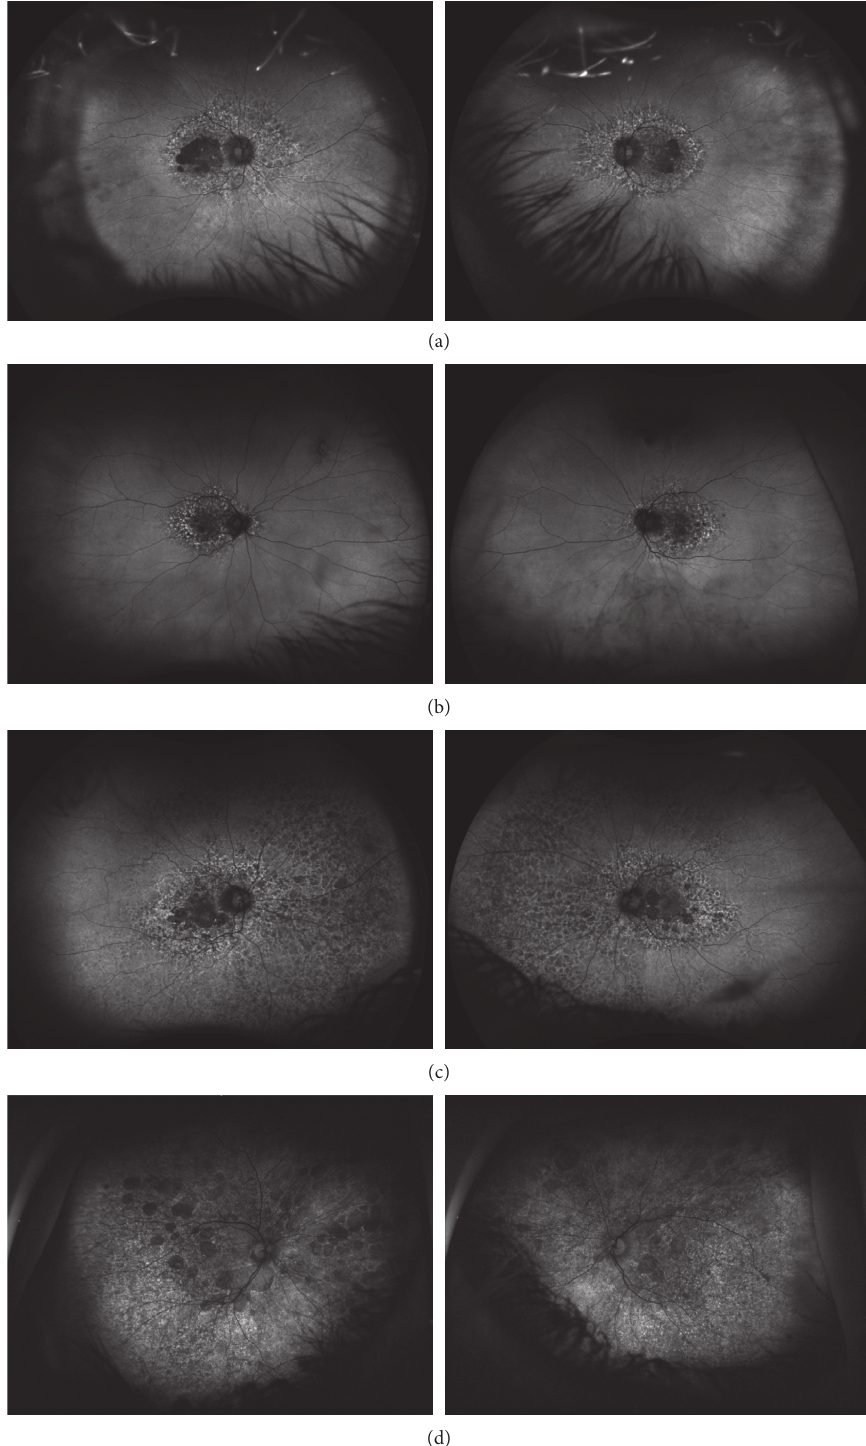
Figure 3: Ultrawidefield fundus autofluorescence imaging demonstrates lobules of absent autofluorescence in the macula of both eyes in patient 1 (a), patient 2 (b), patient 3 (c), and patient 4 (d). These lobules of macular atrophy are surrounded by a larger area of hyper- and hypoautofluorescent changes in the posterior pole of both eyes involving the macula and extending nasally beyond the optic nerve in each case. Patient 3 (c) has extensive peripheral retinal autofluorescence